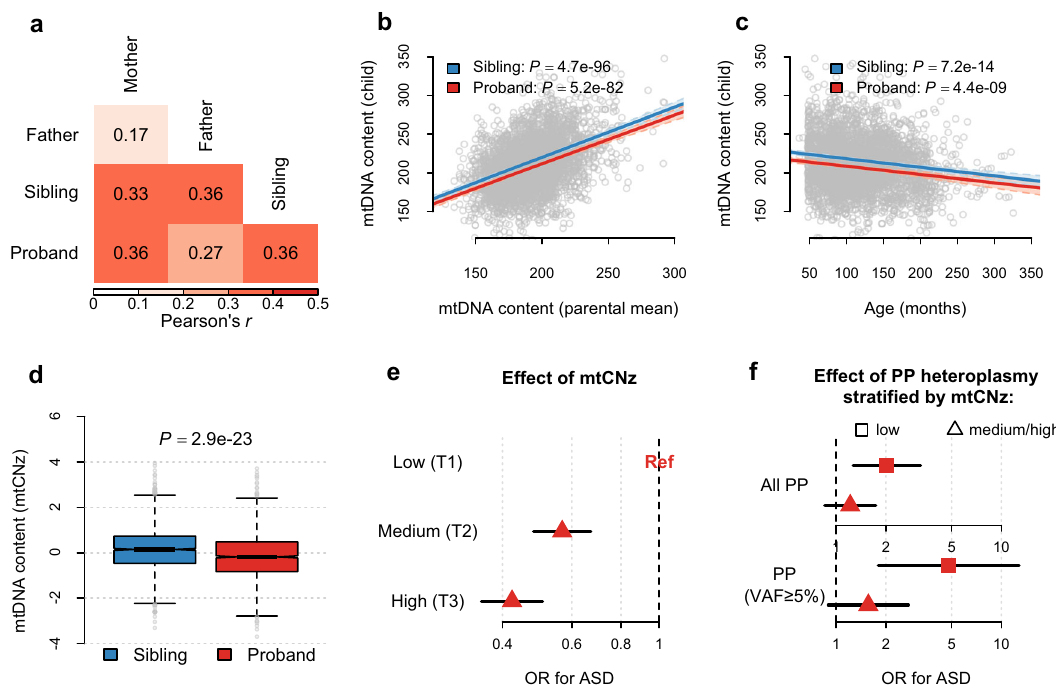
Fig. 4 mtDNA content in the SSC. All analyses were performed in 1938 families of the SSC as illustrated in Fig. 1a. a Pearson ’ s correlation coef fi cients of mtDNA content between the father, mother, sibling and proband. b Scatter plots for mtDNA content in siblings and probands in relation to the mean values of mtDNA content in their parents. c Scatter plots for mtDNA content in siblings and probands in relation to their age at the time of sample collection. 215 siblings with missing age information were excluded. In b and c , the solid lines represent the linear regression lines estimated among siblings and probands, respectively, and the P value (two-sided) indicates the signi fi cance of the slope. d Box plots for the distribution of mtDNA content z-scores (mtCNz) in siblings and probands. All box-plot elements are de fi ned in the same way as in Fig. 1. The P value (two-sided) was obtained from conditional logistic regression, where ASD is the outcome and mtCNz is the predictor. e Forest plots for the effects of mtCNz on ASD risk. The low-tertile group (T1) of mtCNz served as the reference group. f Forest plots for the effects of predicted pathogenic (PP) heteroplasmies on ASD risk among children with low mtCNz (the low-tertile group; T1) vs. medium/high mtCNz (the middle- or high-tertile group; T2/T3). The upper subpanel and lower subpanel show the results for all PP heteroplasmies and PP heteroplasmies with variant allele fraction (VAF) ≥ 5%, respectively. Horizontal black lines represent the 95% con fi dence interval (CI) of the estimated odds ratio (OR). Values on the x axis are shown on a logarithmic in autism symptoms related to repetitive behaviors (OR = 3.52, P = 3.3 × 10 − 6 ), temper (OR = 2.13, P = 0.0029), and commu- nication (OR = 1.97, P = 0.016) relative to probands without PP